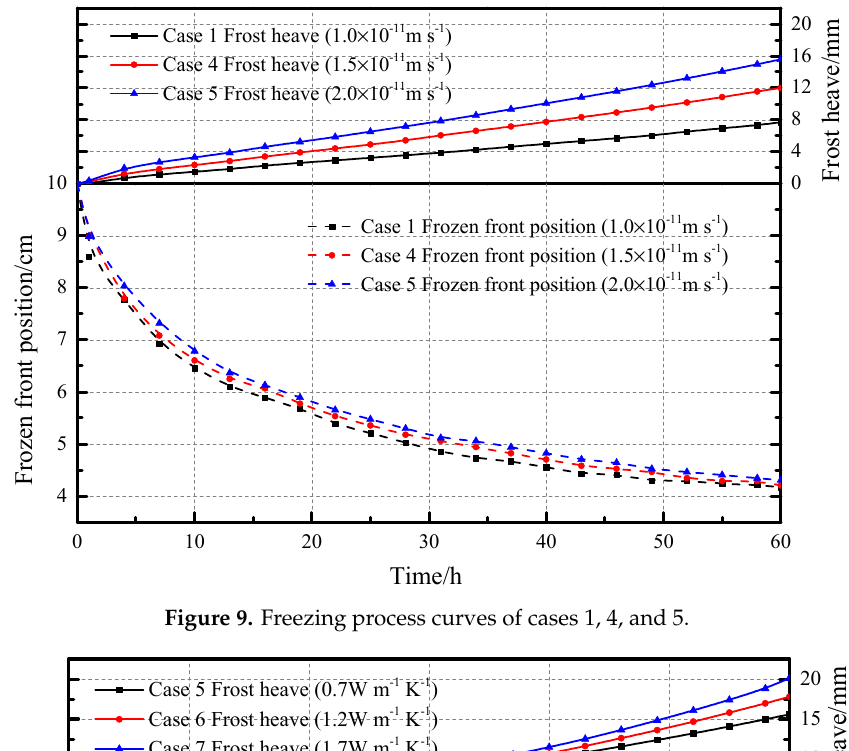
Figure 9. Freezing process curves of cases 1, 4, and 5.